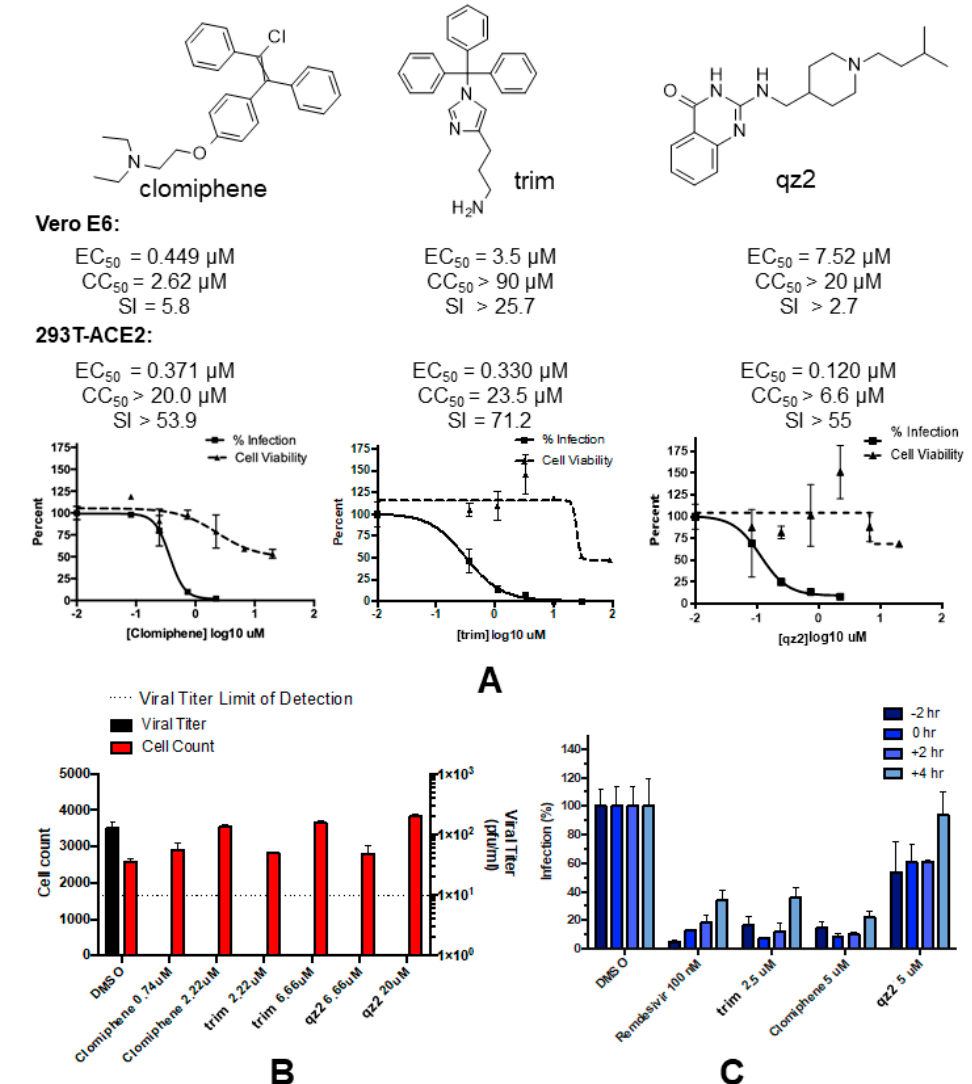
Figure 2. Chemical structure, SCoV2 antiviral activity, and toxicity of the best three RNA-binding SCoV2 inhibitors selected from the phenotypic study. ( A ) Chemical structure and antiviral and toxicity data of clomiphene citrate, trim, and qz2, obtained in Vero E6 and human 293T-ACE2 cells. The dose–response graphs correspond to 293T-ACE2 experiments. ( B ) Virus titers determined in supernatants by TCID 50 at 48 h post-infection, with DAPI cell count from the well indicated. The limit of detection for viral titers is indicated with a dotted line. ( C ) Time-of-addition assays analyzing the antiviral action of clomiphene citrate, trim, and qz2. The data were normalized to the mean of DMSO-treated cells at each time point, and remdesivir was used as a positive control.